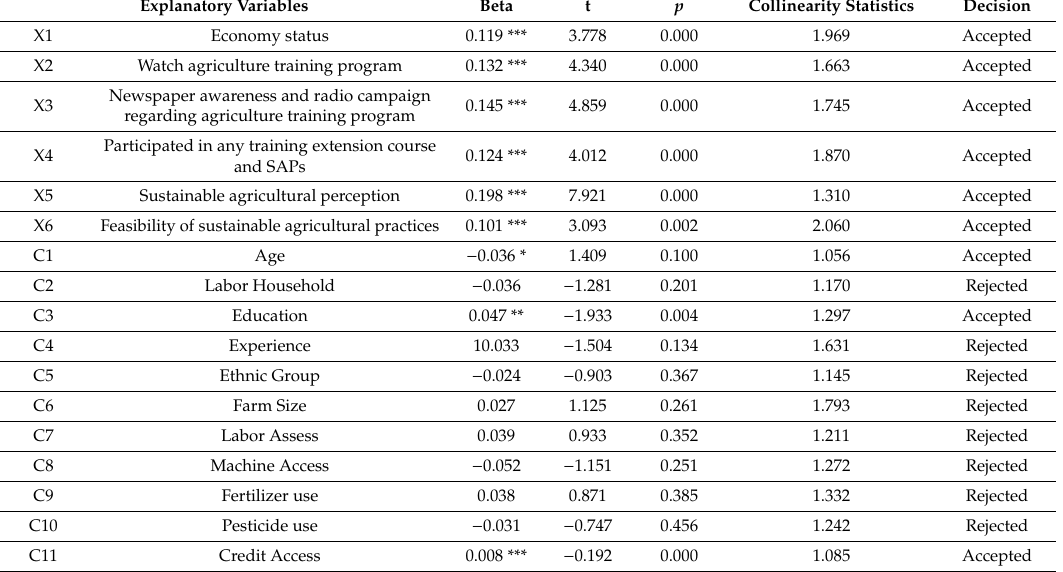
Table 6. Results of LR